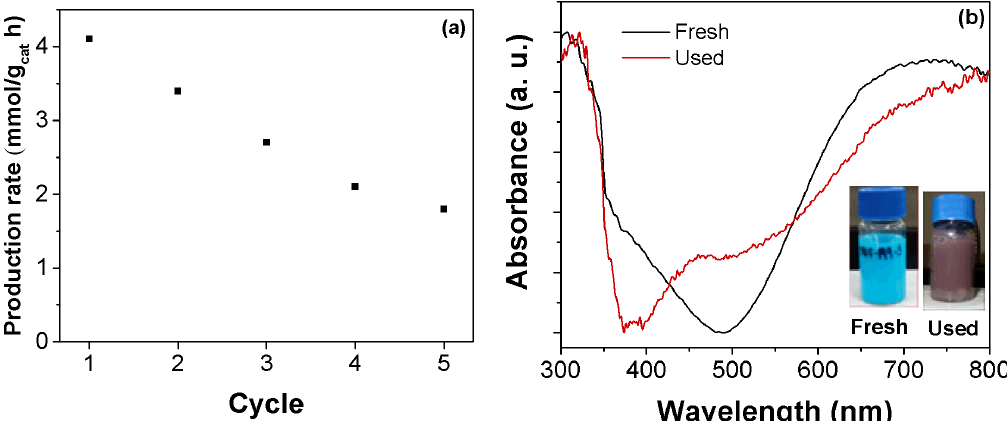
Figure 2. ( a ) Photocatalytic stability tests of 50TiO 2 P25/syn-HKUST-1, under simulated solar light, ( b ) UV-Vis diffuse reflectance spectra (DRS) of fresh and spent 50TiO 2 P25/syn-HKUST-1 composites.